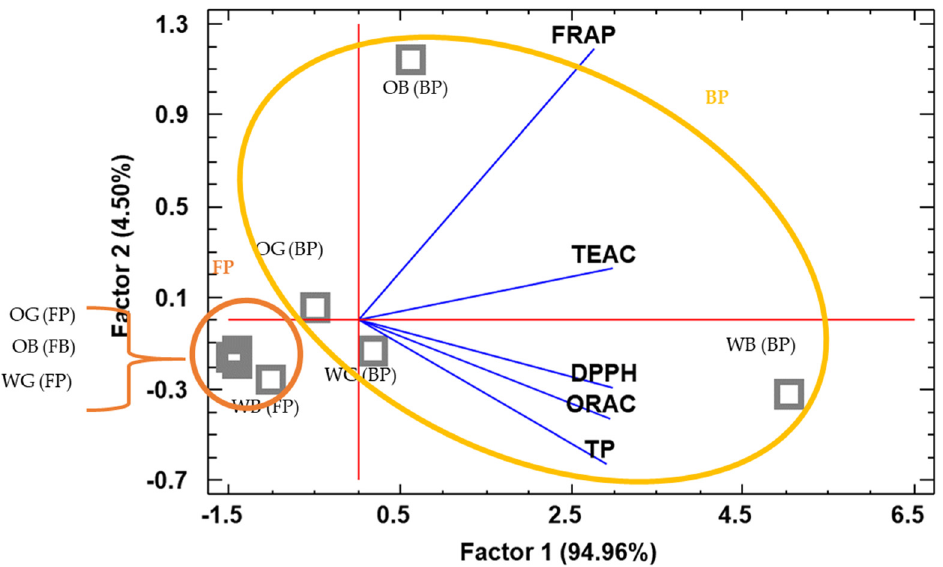
Figure 6. PCA analysis of wheat grain (WG), oat grain (OG), wheat bran (WB), and oat bran (OB). Orange and yellow circles group scores for free (FP) and bound (BP) phenolics, respectively.